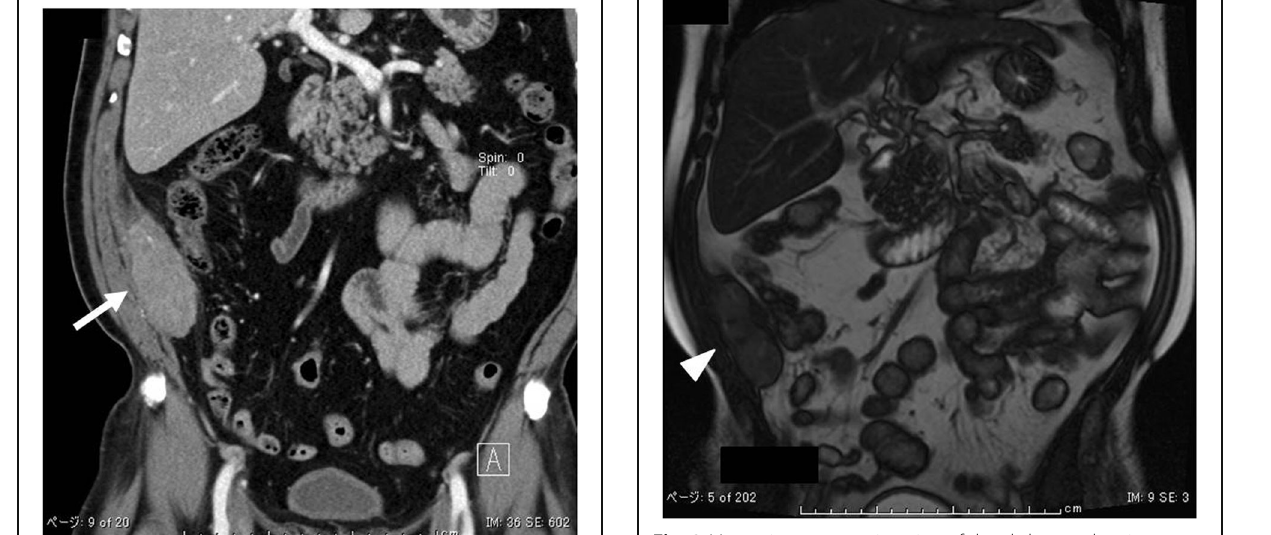
Fig. 3 Magnetic resonance imaging of the abdomen showing elliptical masses in the transverse abdominal wall exhibiting low intensity on T2-weighted images